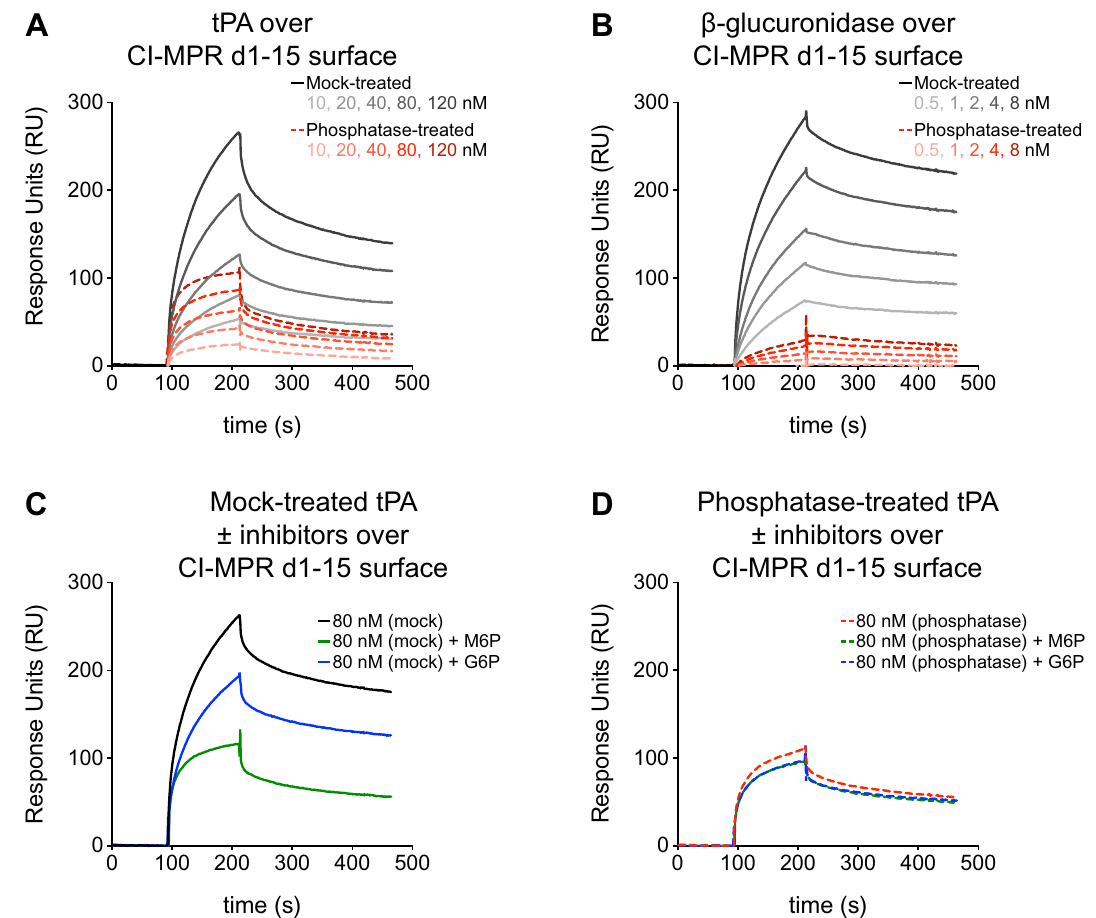
Figure 2. What is the nature of the interaction between tPA and CI-MPR? Bovine CI-MPR d1–15 was immobilized to a sensor chip by amine coupling. ( A ) Mock- or phosphatase-treated recombinant tPA were injected at various concentrations. ( B ) Mock- or phosphatase-treated β-glucuronidase were injected at various concentrations. ( C ) At a concentration of 80 nM, mock-treated recombinant tPA was injected over the bovine CI-MPR d1–15 surface in the presence of 5 mM M6P, 5 mM G6P, or no inhibitor. ( D ) Same as in ( C ), but recombinant tPA was treated with phosphatase. Note that the M6P and G6P sensorgram curves overlay.